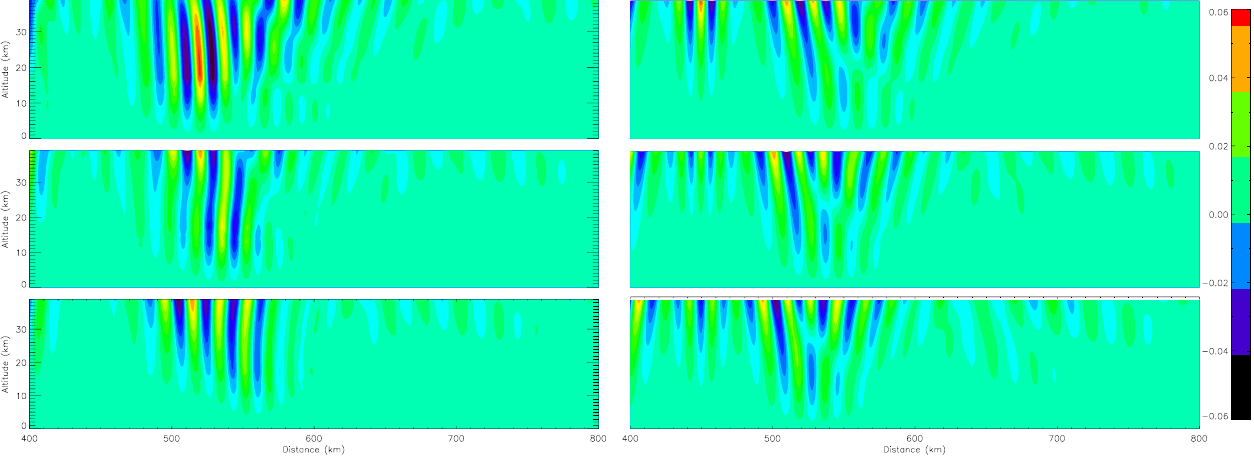
Fig. 6. Vertical velocity simulation results similar to Figure 5, but with a 1-km RMS wind width. The left column shows the results of the simulation with a Doppler duct located at ∼ 15-km for three progressively increasing time intervals of 12000-s/3.33-hr, 14000-s/3.89-hr, and 16000-s/4.44-hr. The right column shows the results from the simulation without a Doppler duct at the same time intervals. Color-bar units are in m/sec.